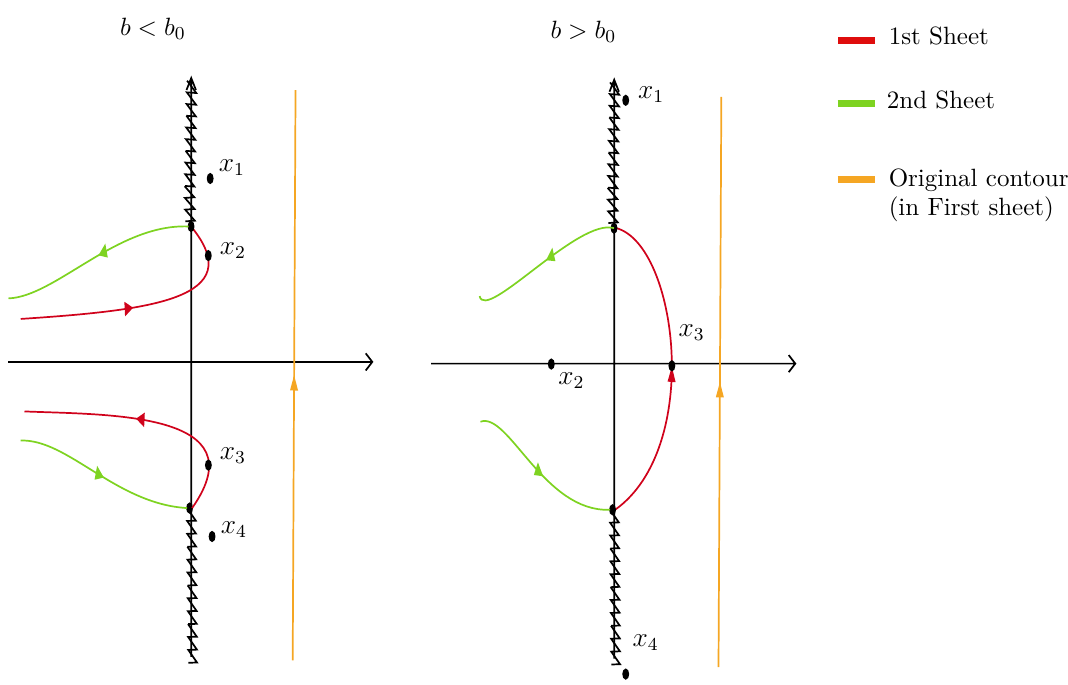
Figure 10 . Double trumpet